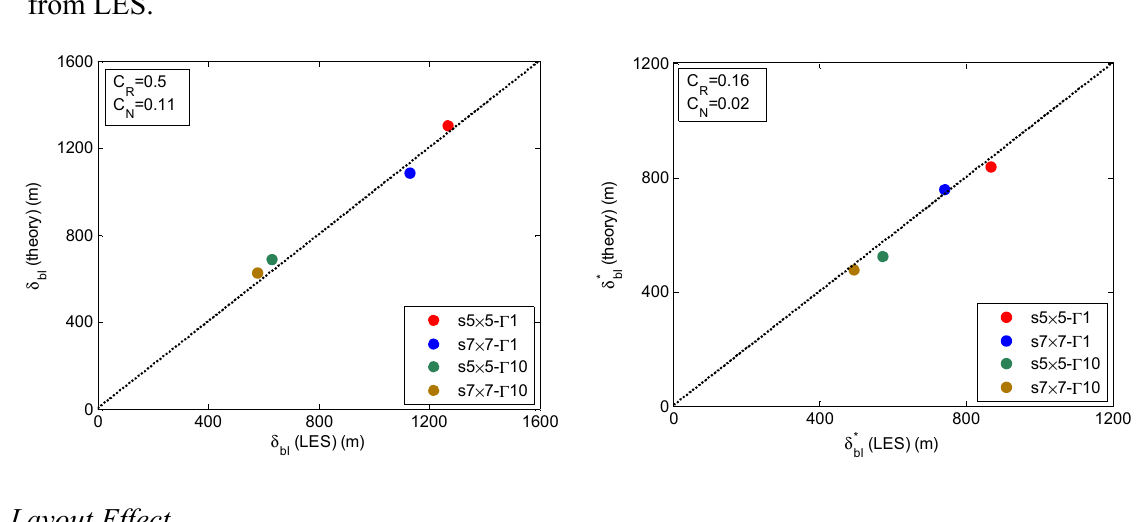
and δ (cid:2912)(cid:2922)∗ theory and their counterparts directly obtained (cid:2912)(cid:2922)